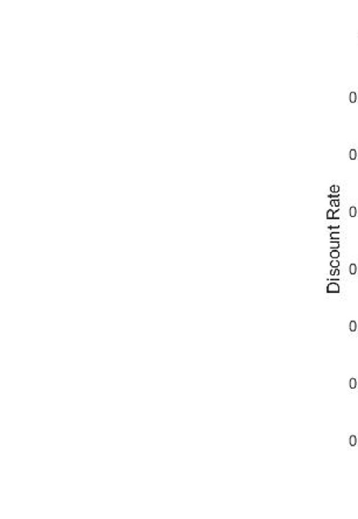
FIGURE 3 | Discount rate comparison between GTS and